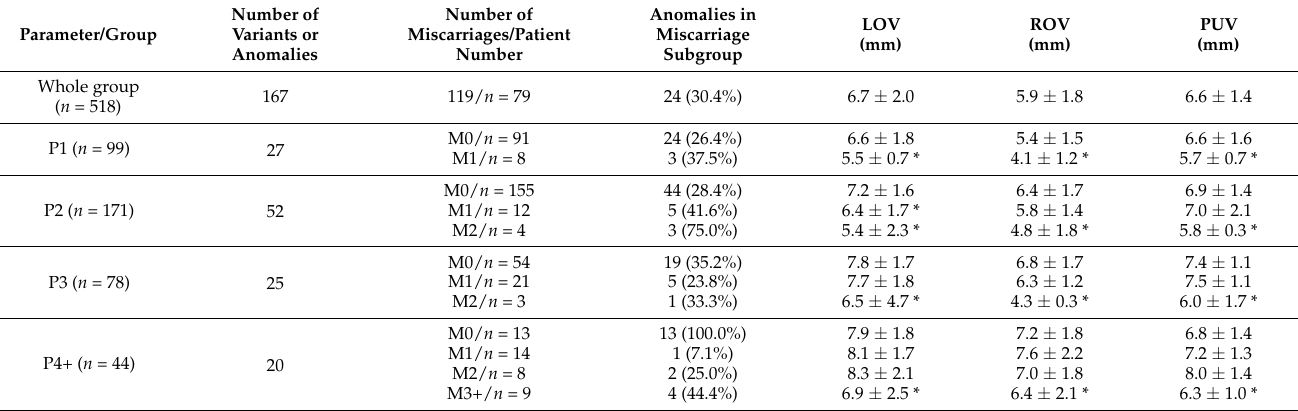
The values shown in the table represent mean ±SD, as well as the number (percent) of cases within the respective group. Abbreviations: SD: standard deviation, LOV: left ovarian vein, ROV: right ovarian vein, and PUV: parauterine vein. The values marked with asterisks (*) were statistically significantly different compared to corresponding values in the respective subgroup without miscarriages